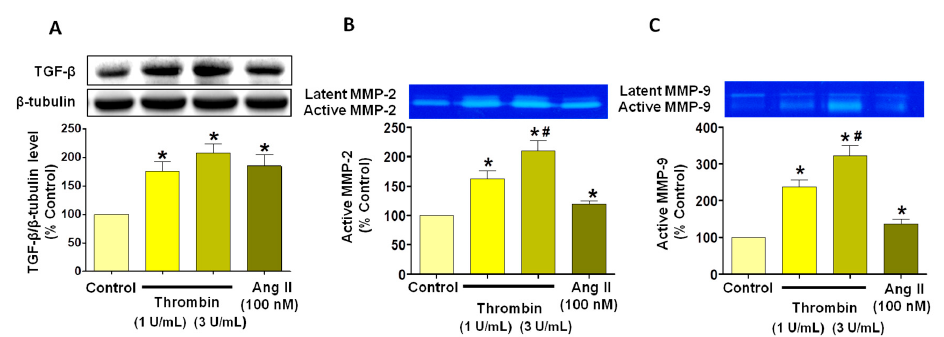
Figure 5. Thrombin- and AngII-induced senescence promotes pro-fibrotic phenotype in atrial ECs. Atrial ECs were untreated or exposed to either thrombin (1 or 3 U / mL) or AngII (100 nM) before determination of the expression level of TGF- β ( A ) as assessed by Western blot analysis, and MMP-2 and 9 activities by zymography ( B, C ). Results are shown as representative immunoblots or gelatinolytic activity (upper panels) and corresponding cumulative data (lower panels) and shown as mean ± SEM, n = 3–4, * P < 0.05 versus respective